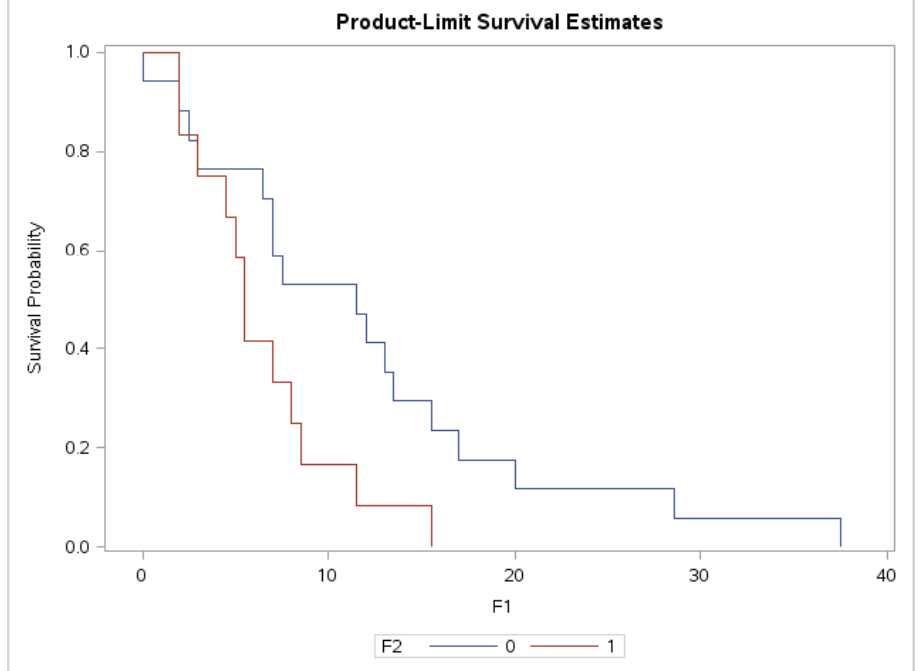
Figure 1. Kaplan – Meier survival curves of grade IV according to sHLA-G. 0 — patients with sHLA- Figure 1. Kaplan–Meier survival curves of grade IV according to sHLA-G. 0—patients with G < 40 ( n = 17), 1 — patients with sHLA-G > 40 ( n = 12), X-axis — survival time in months, Y-axis — sHLA-G < 40 ( n = 17), 1—patients with sHLA-G > 40 ( n = 12), X-axis—survival time in months, survival probability (test: Log rank p = 0.038). Y-axis—survival probability (test: Log rank p = 0.038).